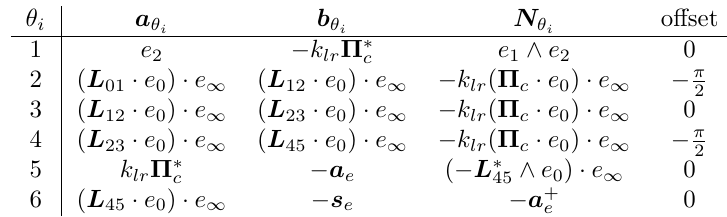
is the rotational axis i